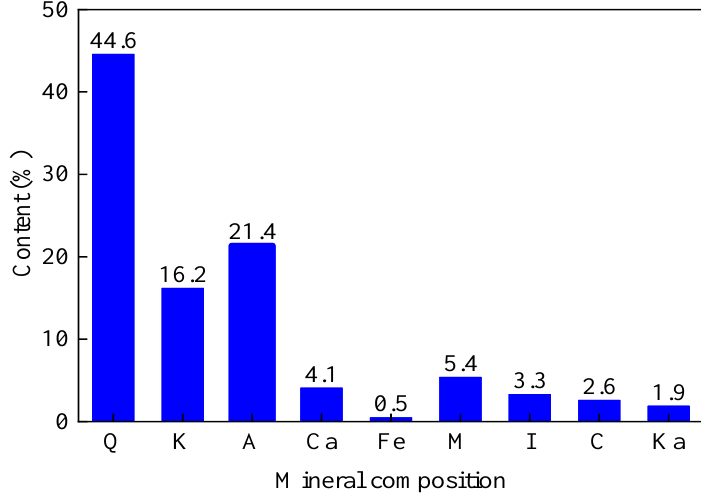
Figure 4. Mineral composition diagram.